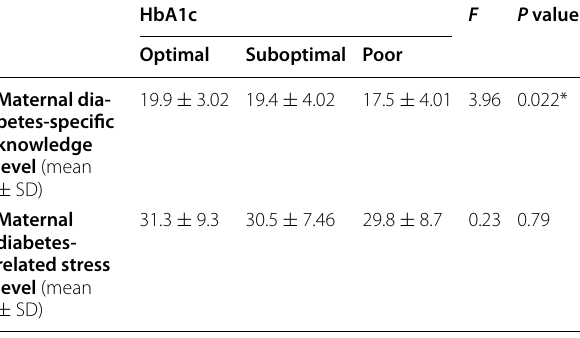
Table 2 Relationship of maternal diabetes-specific knowledge, maternal stress levels, and glycemic control of their